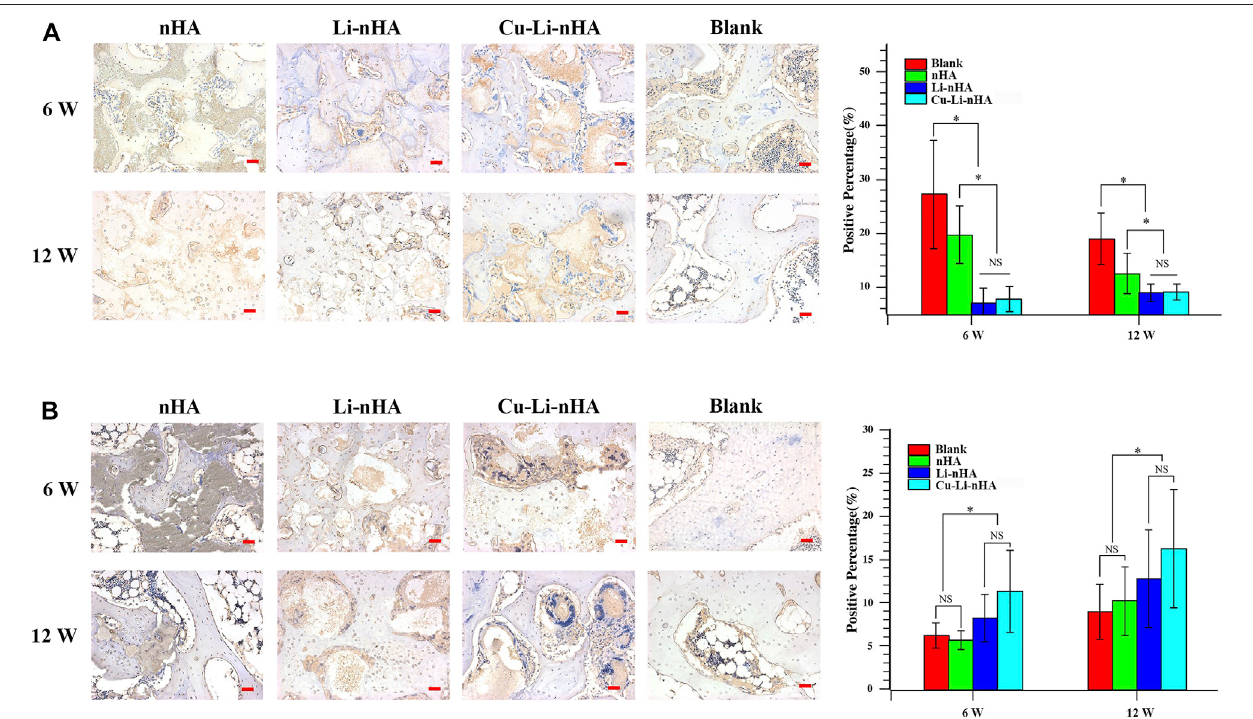
FIGURE 9 | Immunohistochemistry and positive ratio analysis of GSK-3 β (A) , β -catenin (B) . Blank Group: without ONFH modeling and scaffold-implantation operation.Scalebarinthebottomright-handcorner ofeachimage (red):100 μ m.Statisticalanalysiswasconducted usingaone-wayanalysisofvariancewithpost-hoc Bonferroni ’ s multiple comparisons test. NS: p > 0.05, * p <